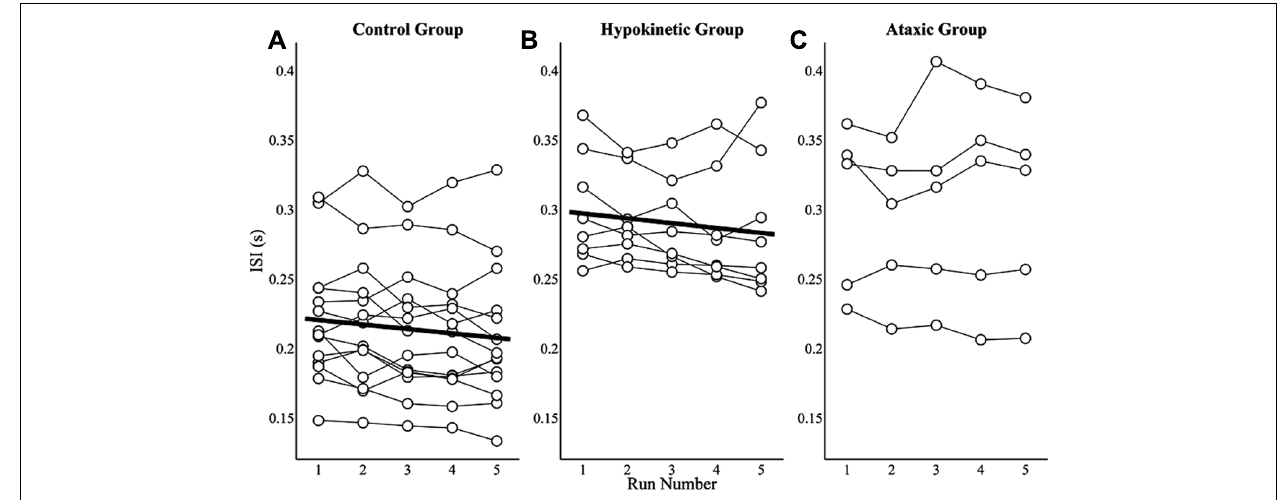
FIGURE 5 |The effects of practice on average ISIs are depicted by run for the healthy speaker group (A), the hypokinetic speaker group (B), and the ataxic speaker group (C) . Significant effects were observed in the healthy speaker group and hypokinetic group with Parkinson’s disease but not in the ataxic speaker